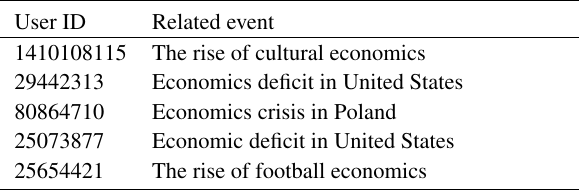
Table 7 Results of identification of influential spreaders in related event.